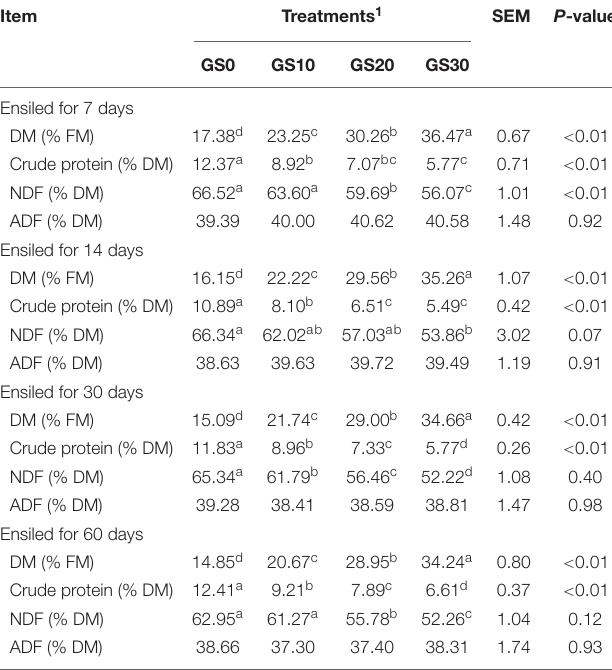
TABLE 2 | Chemical composition of Pennisetum hydridum ensiled with garlic